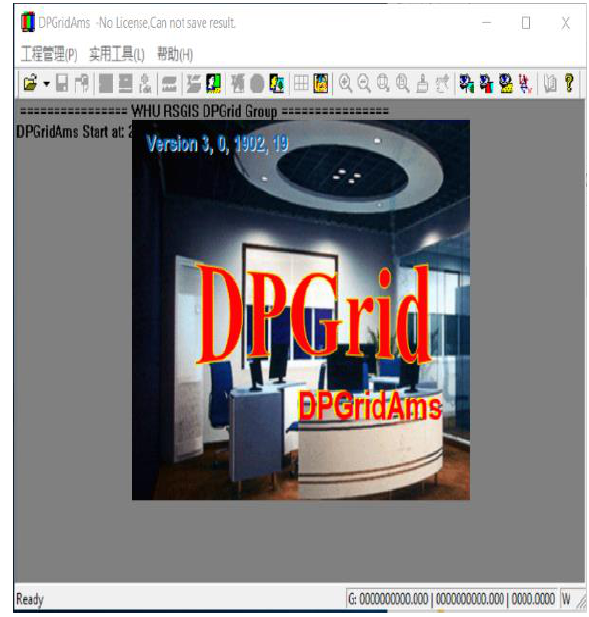
Figure 3. The software main interface of DPGridAMS With AMS-3000 system, we tested the hardware and software performance of the camera in Yangjiang city, Guangdong province, China. In this production test, the Y-12 type fixed-wing aircraft was used to fly 5 sorties with AMS-3000 digital aerial camera. The effective area obtained was over 1000 square kilometers, and the ground resolution was about 0.1 meter (2000m flight height). The experimental area has many land types, namely, water, residential, forest and coast. The CCD of three bands of AMS-3000 camera is placed on the focal plane with a distance of 10 microns, and the calibrated panchromatic image is used to automatically calibrate the multi-spectral camera. The calibration parameters of RGB image can be obtained, and the three bands of RGB can be registered to within 2.5 microns through the calibration parameters. The design length of CCD for each row is 163.78mm, and the calibrated average length is 164.512mm. The design values of the front and rear CCD viewing angles of the AMS-3000 are 21 degrees and 27 degrees, respectively. The mean viewing angle before calibration is 21.12 degrees, and the mean viewing angle after calibration is 27.21 degrees. The intersection angle during stereo measurement is 48.33 degrees, and the base-to-height ratio of photogrammetry is 0.95